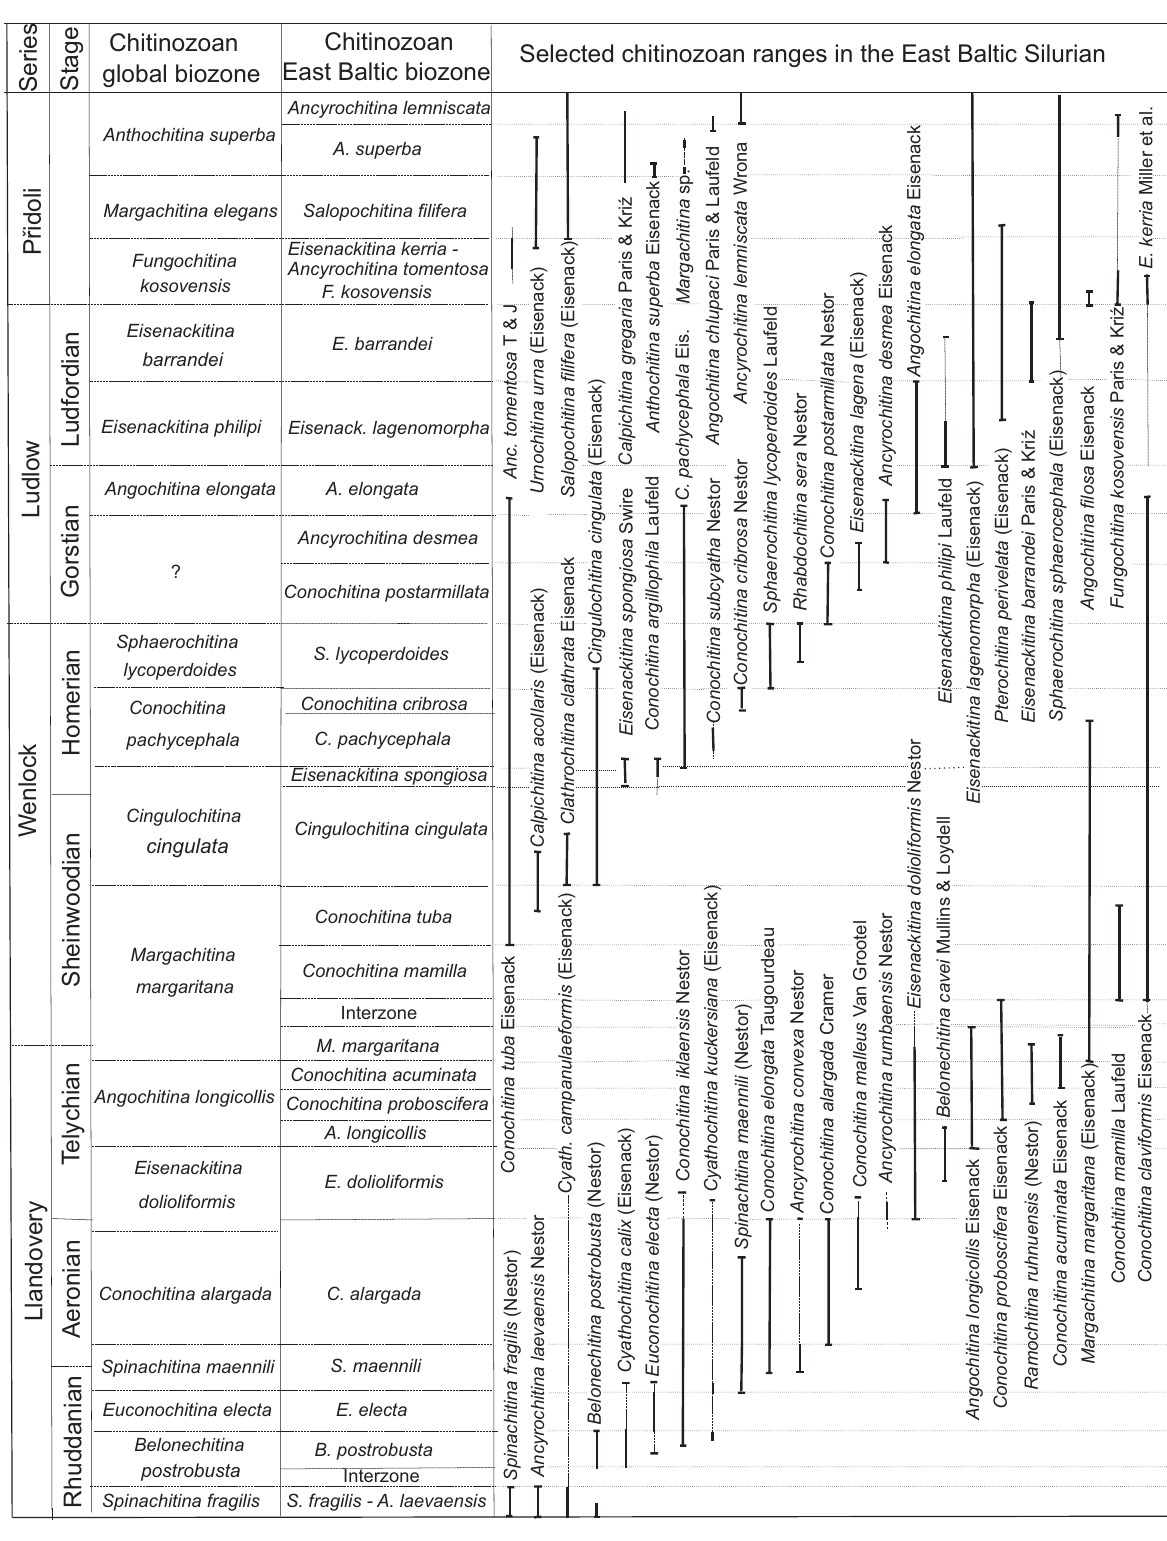
Fig. 2. The ranges of the stratigraphically most important chitinozoan species in the East Baltic Silurian and correlation of the global (Verniers et al. 1995) and regional chitinozoan biozones. Thin lines of the ranges indicate problematic identifications or scattered presence of a